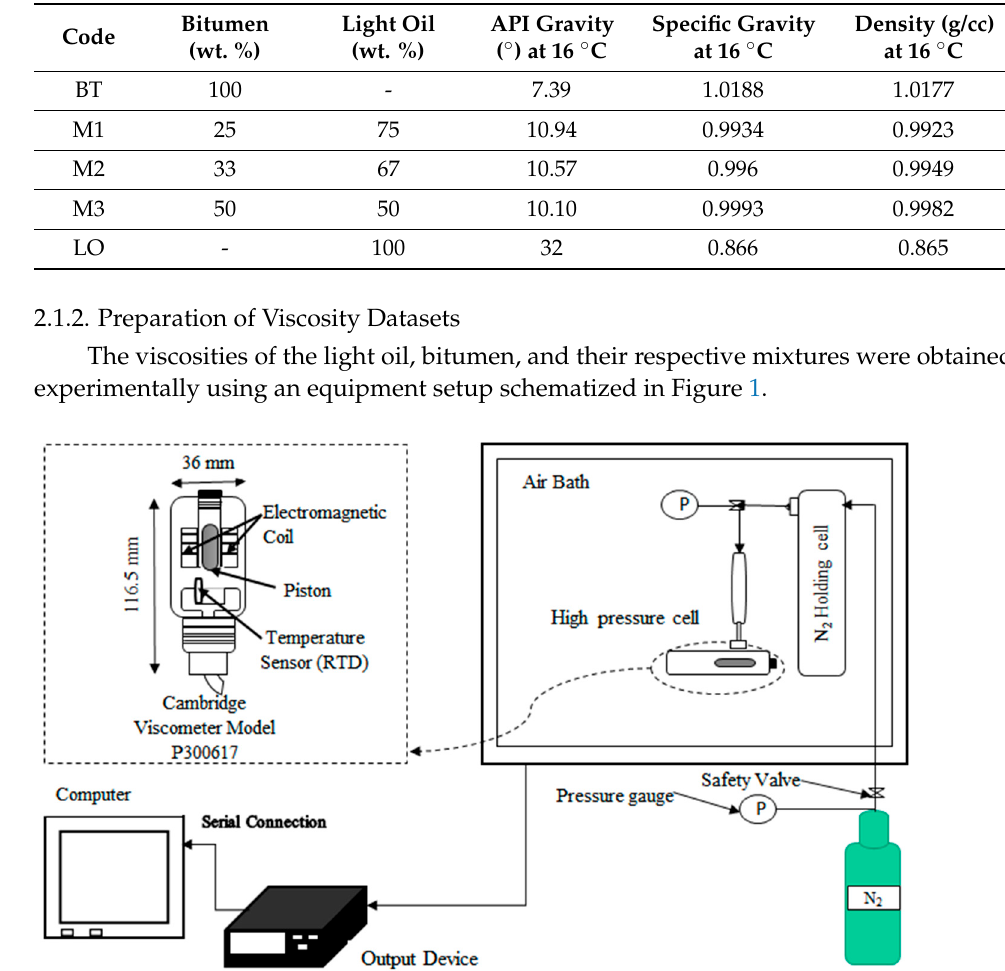
Table 1. The samples in this study based on weight